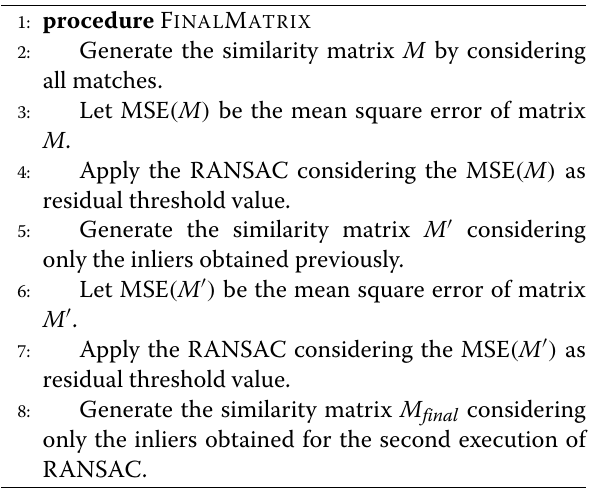
Algorithm 1 Similarity matrix computation